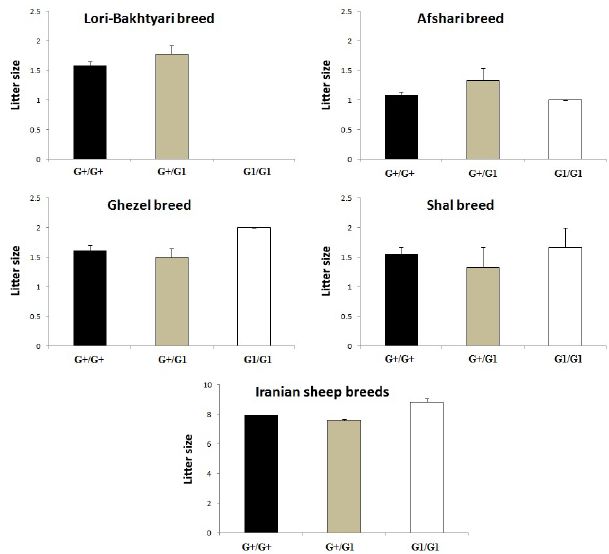
Figure 4. Litter size of Iranian ewes carrying the G4 mutation in the GDF9